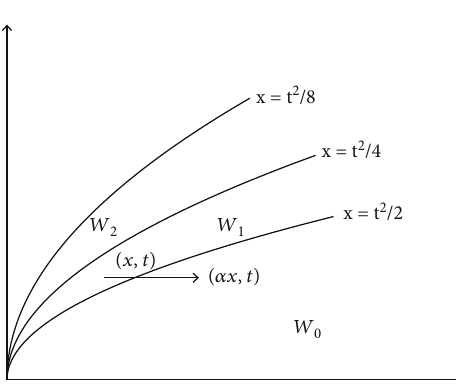
Figure 1: The construction of wedges for the case r ð t Þ = t and α = 2 :